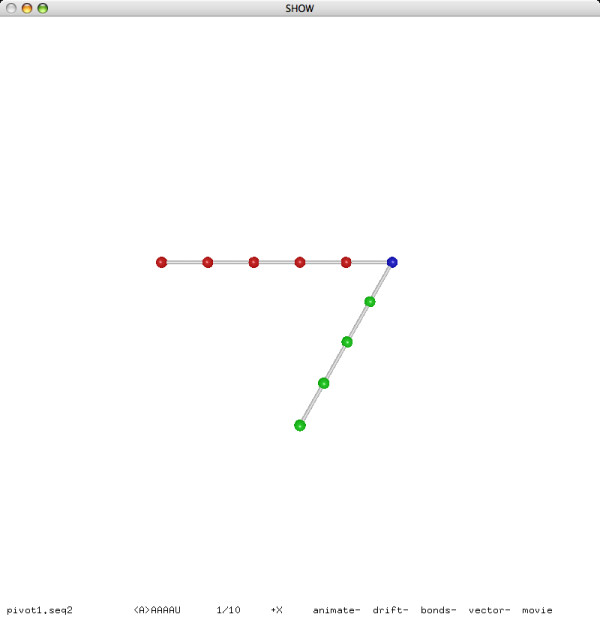
A pivot move (after).